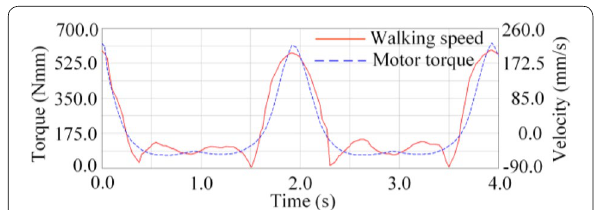
Figure 14 Simulation analysis of climbing slope